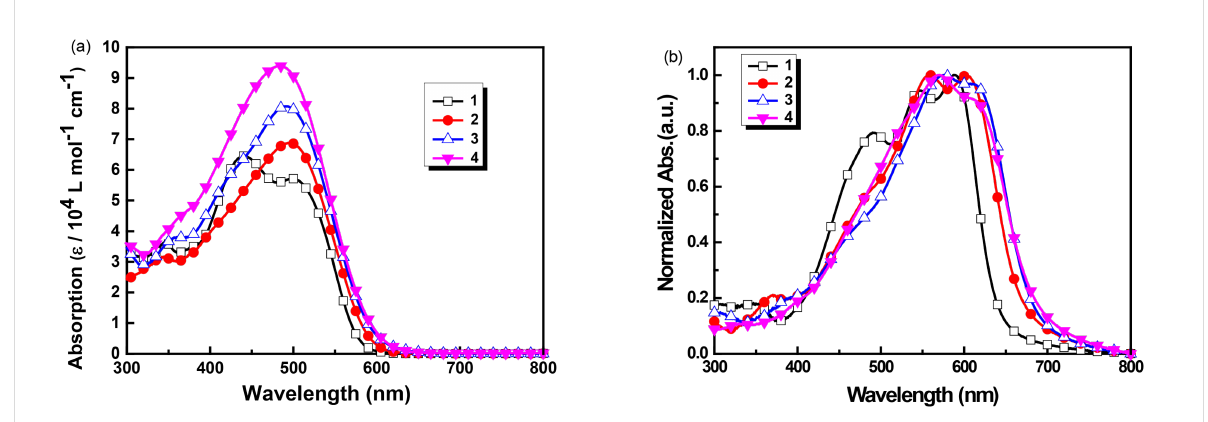
Figure 1: UV − vis absorption spectra of COOP- n HT-TBDTs 1 – 4 (a) in chloroform solution (5.0 × 10 − 5 mol·L -1 ) and (b) in solid films.